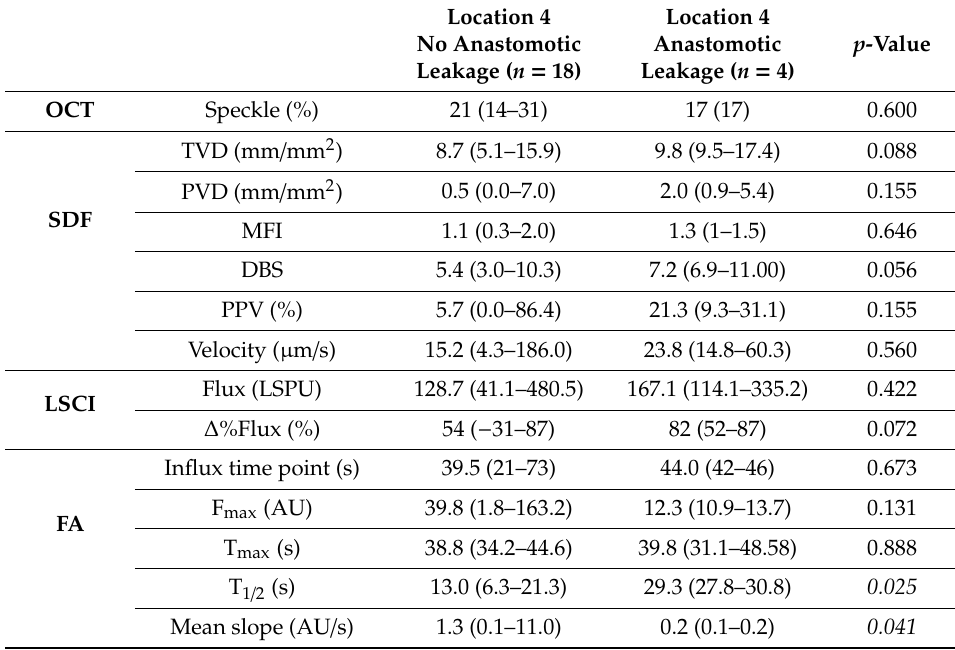
Data are shown as median and total range. OCT Optical Coherence Tomography, SDF Sidestream Darkfield Imaging, TVD total vessel density in mm / mm 2 , PVD perfused vessel density in mm / mm 2 , MFI microvascular flow index, DBS de Backer score, PPV proportion (%) of perfused vessels, LSCI Laser Speckle Contrast Imaging, Flux in LSPU (laser speckle perfusion units), ∆ %Flux percentage di ff erence in Flux relative to Location 1, FA Fluorescence Angiography, F max in arbitrary units, mean slope in arbitrary units per